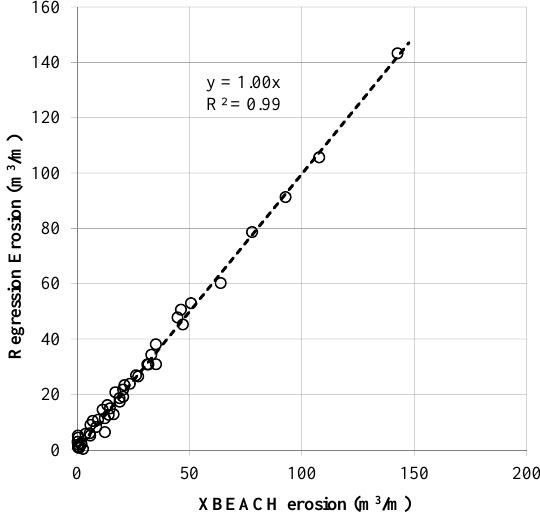
Fig. 5. A comparison of the erosion estimated from the multiple linear regression and XBEACH.